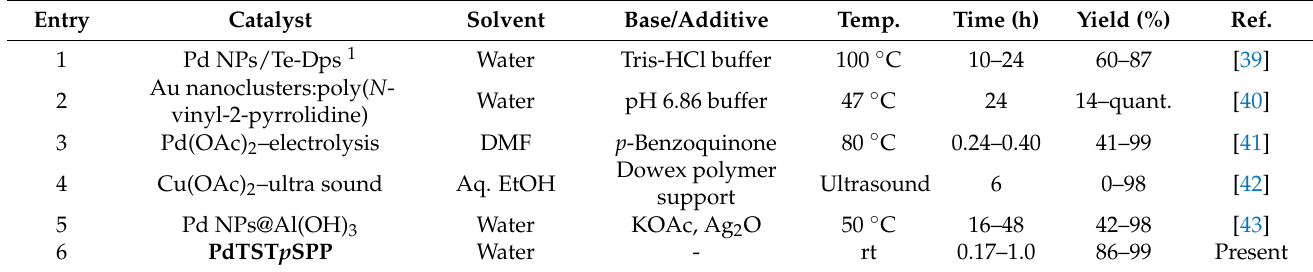
Table 3. Comparison of self-couplings of aryltrifluoroborates.